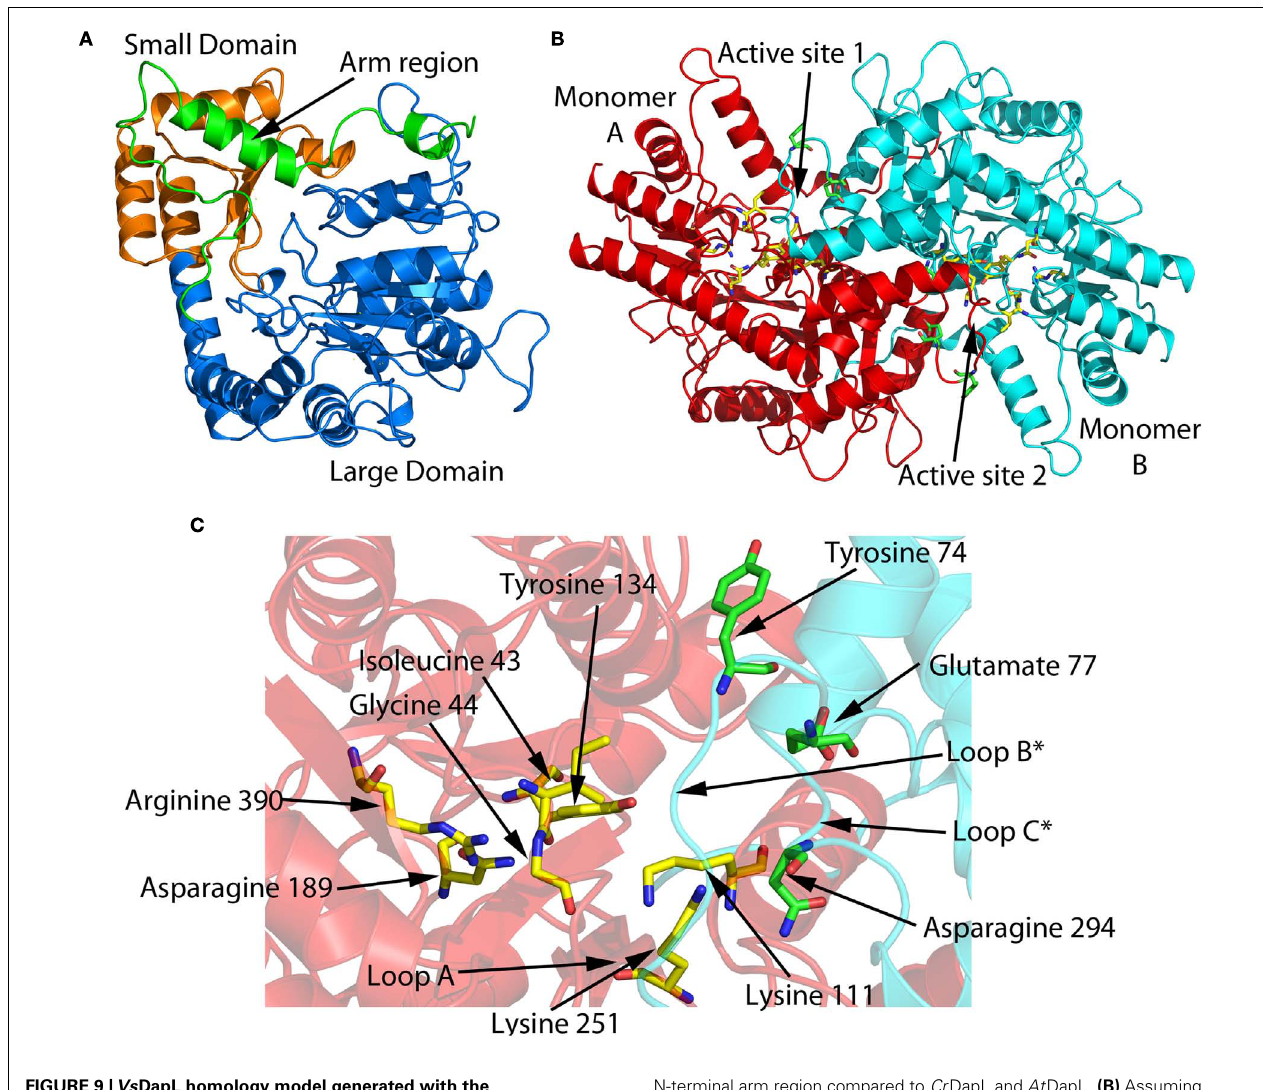
FIGURE 9 | Vs DapL homology model generated with the Swiss-Model Protein Modeling Server (Arnold et al., 2006) using the Cr DapL apo structure as a template (PDB id: 3QGU Dobson et al., 2011; Hudson et al., 2011a, BLAST identity = 51% (207/404 residues), QMEAN4 score = 0.673). (A) The domain structure of the monomer. Note that, as seen in Figure 8 , Vs DapL has a truncated